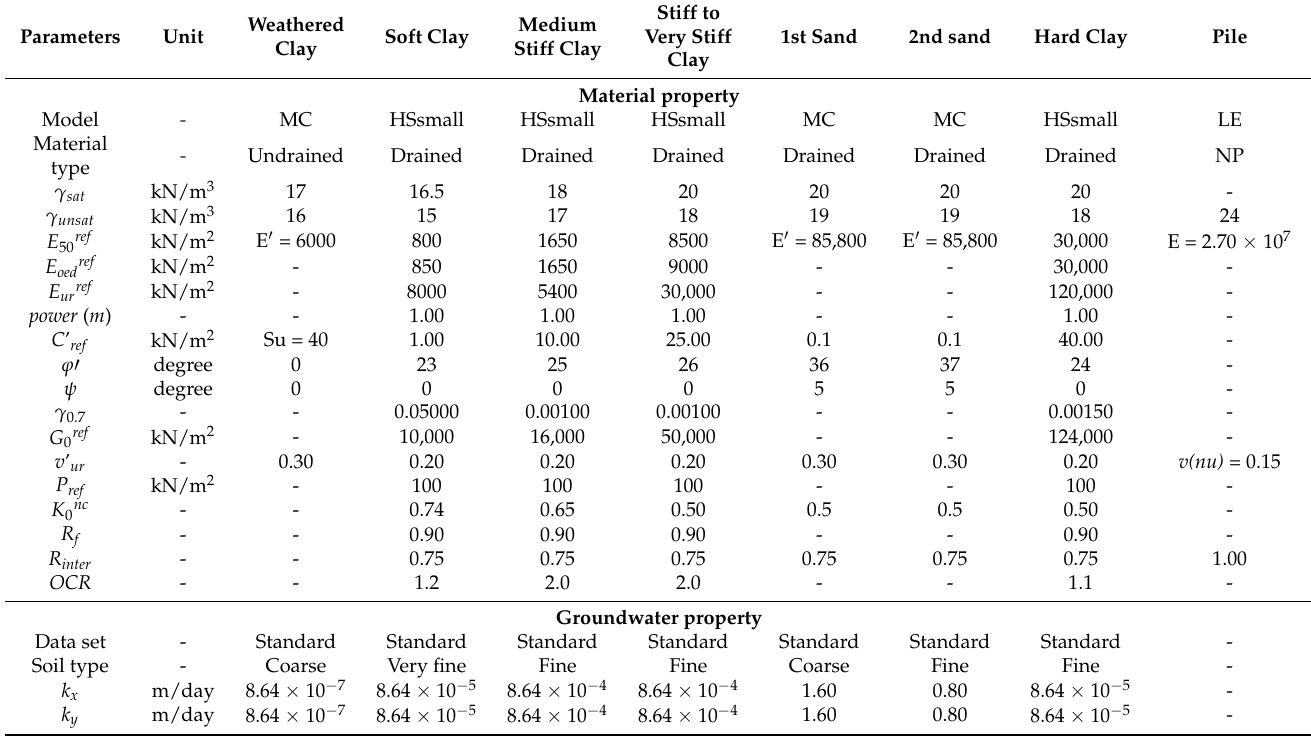
Table 3. Model parameters used in